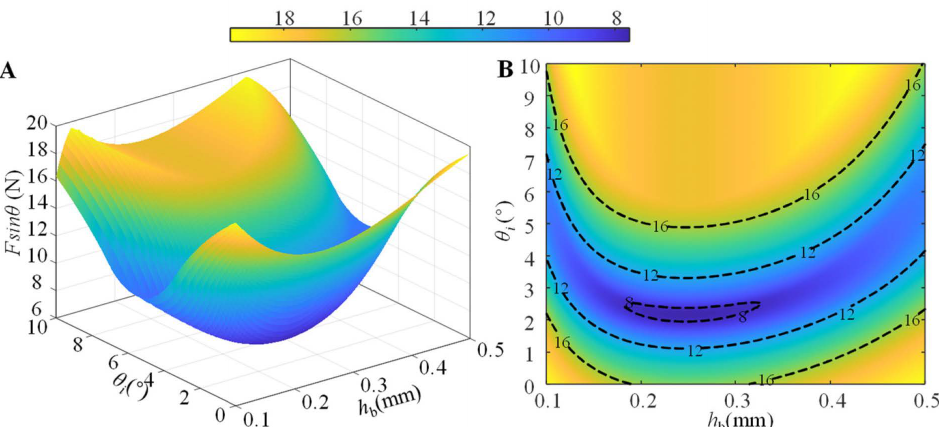
Figure 11. ( A ) Three-dimensional plot of the inclination angle θ 0 and the thickness h b of the RBL for the normal peeling force F sin θ ; ( B ) the projection of the iso- F sin θ line on the h b - θ 0 plane. The compression force P = 16 N is used in the